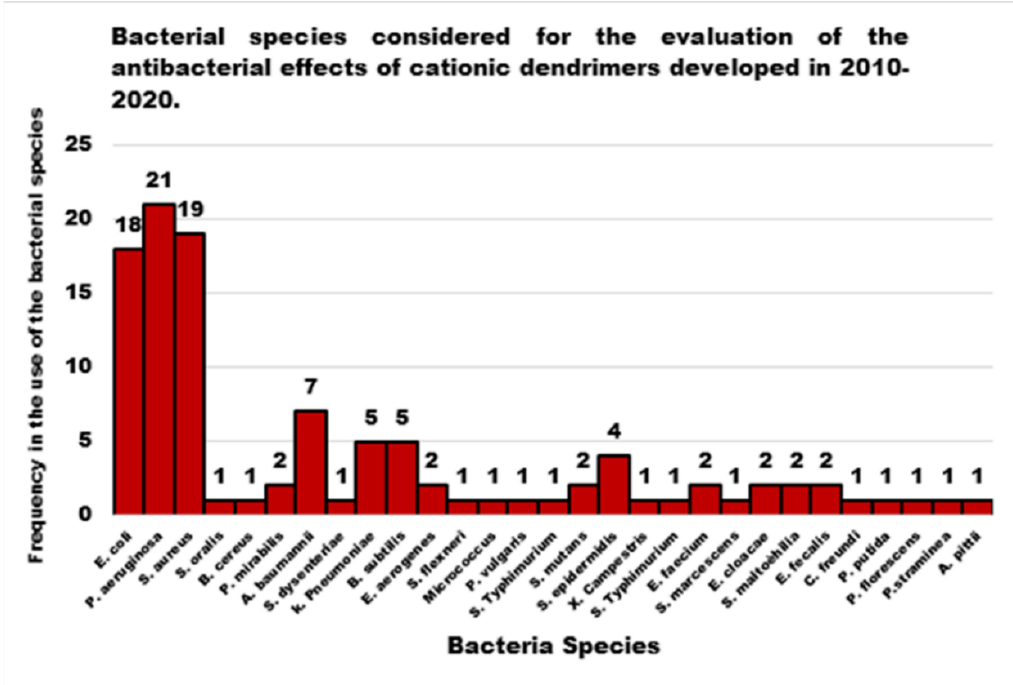
Figure 4. Bacterial species employed to evaluate the antibacterial activity of cationic Ds.